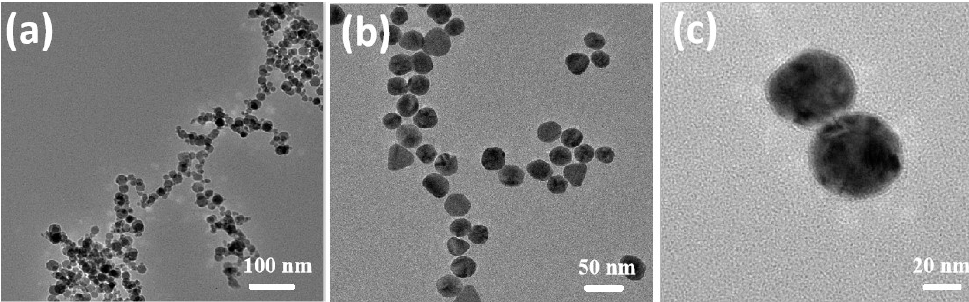
Figure 1. Representative transmission electron microscopy (TEM) images of ( a ) Au@MPA, ( b ) Au@MPA-HA-PEG-ADH, and ( c ) Au@MPA-HA-PEG-ADH-Dox.